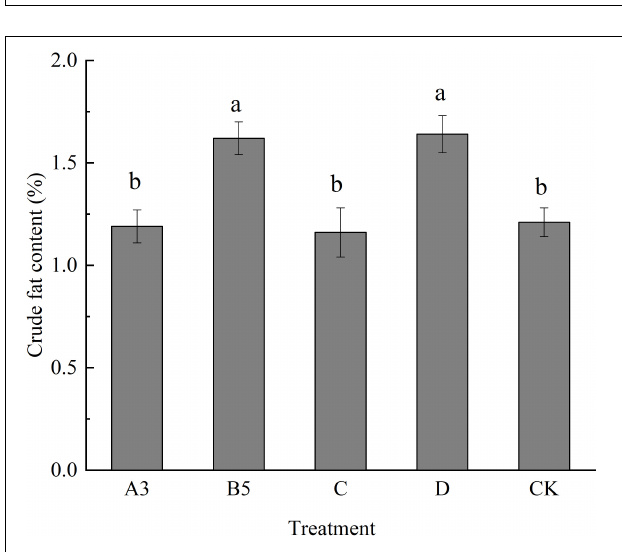
FIGURE 4 | Crude fiber content of fruiting bodies of each treatment. Different letters in the figure indicate significant differences ( P < 0.05).